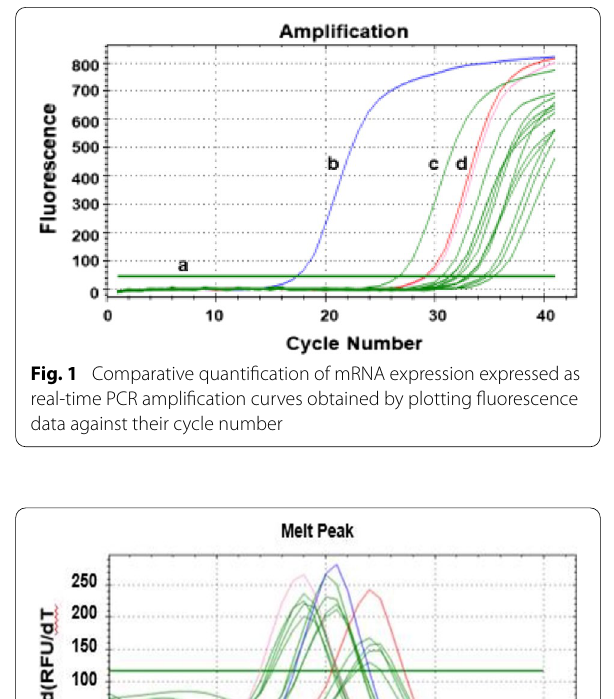
Table 1 Relative expression of BAMBI and Survivin in oral squamous epithelial cells from mobile phone users Group Number of BAMBI ± participants